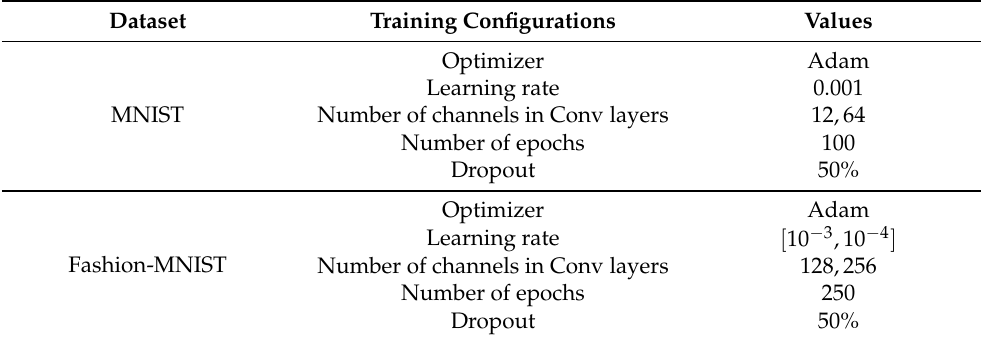
Table 1. Training configurations for both datasets.